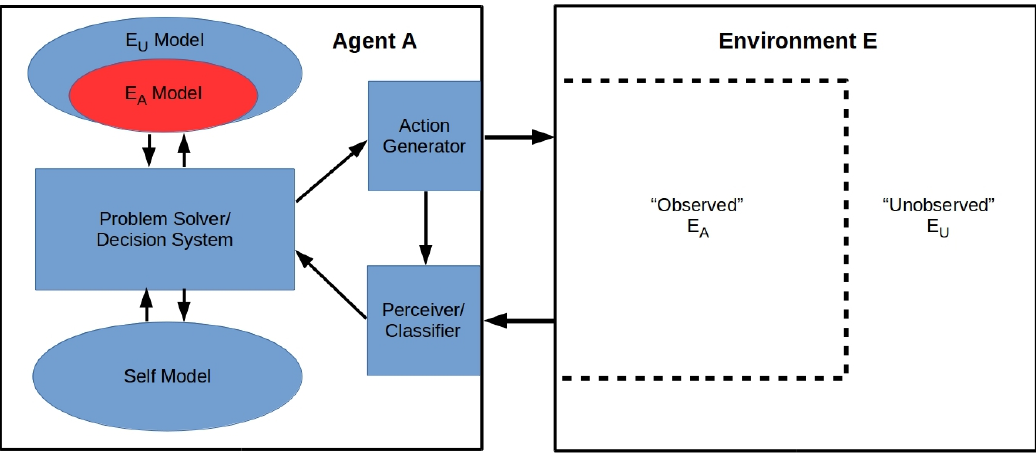
Figure 1. General set-up for the Frame Problem (FP): a finite agent A interacts with an environment E . The agent has perception and action modules and a problem solver. The problem solver has access to two generative models, one of the environment and the other a “self” model of its own problem-solving capabilities. The environment is divided into a part E A to which A has observational access and a remainder E U to which A does not have observational